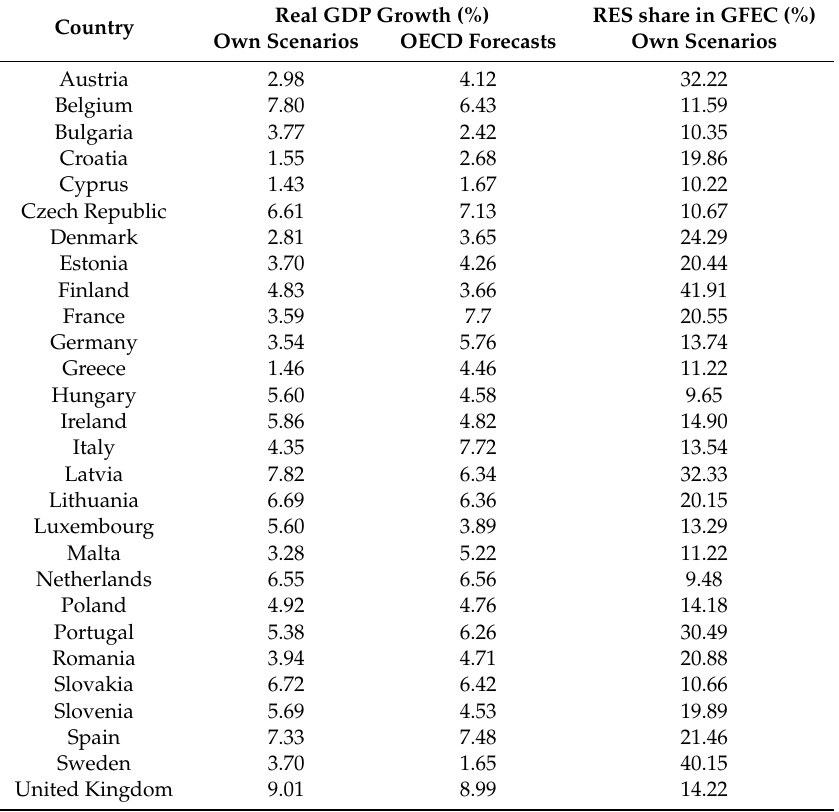
Table 11. Forecasts for real GDP growth and RES share in GFEC (%) in the EU countries and UK for